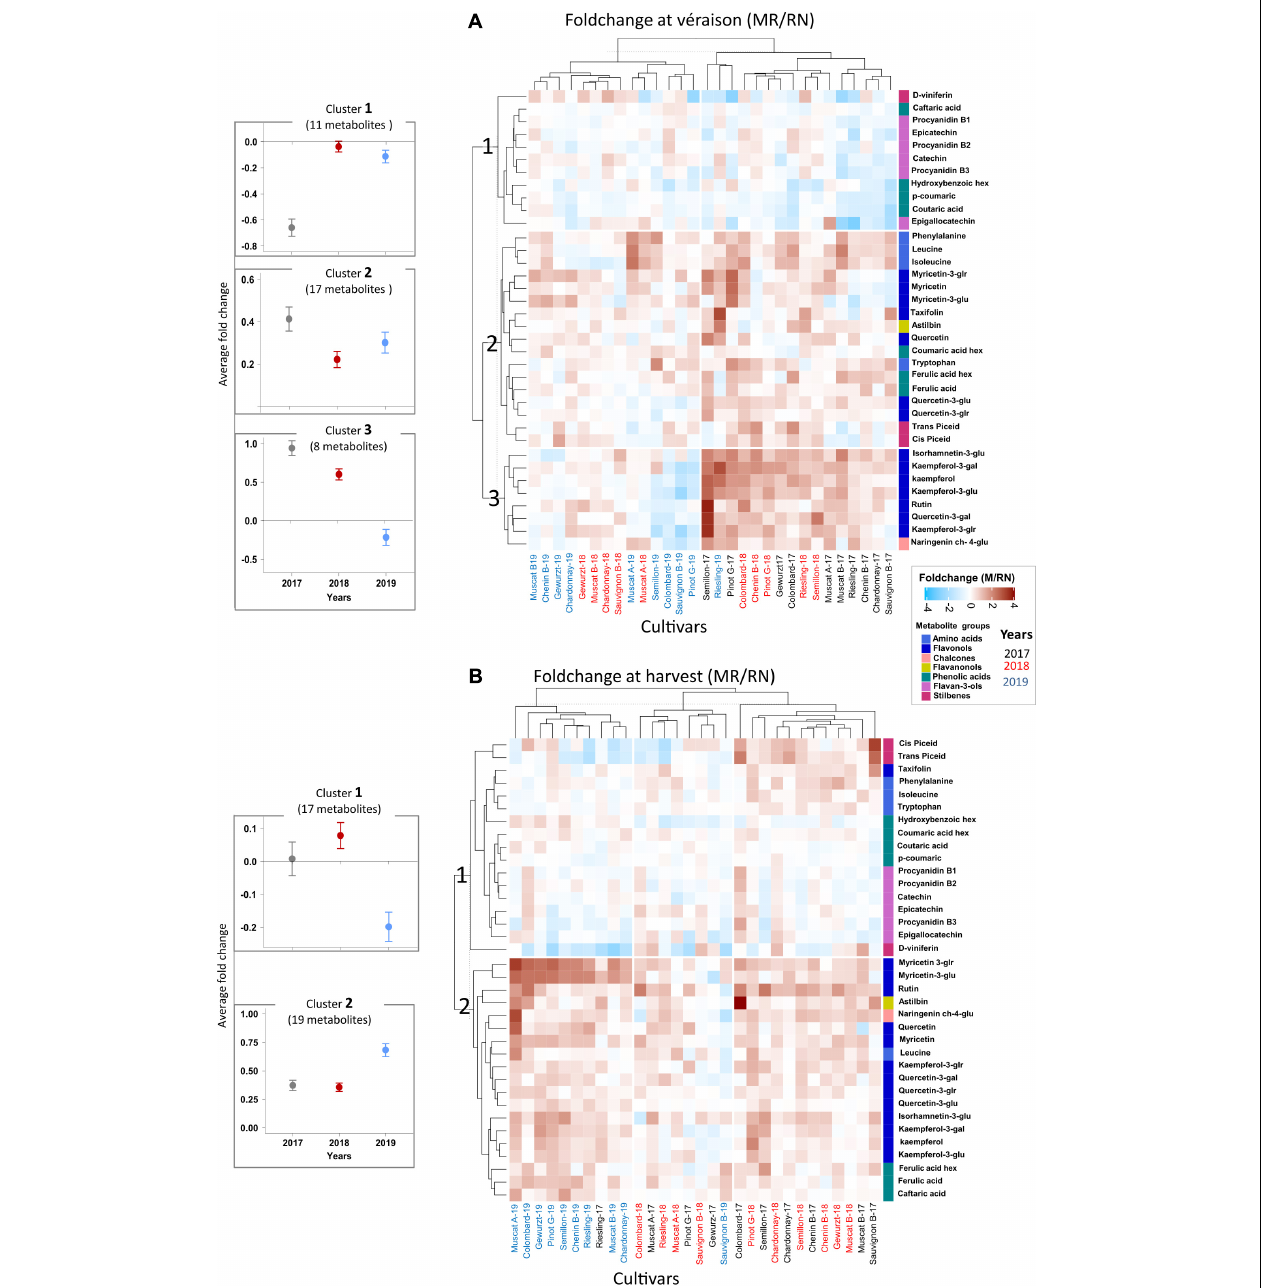
FIGURE 4 | The variability in skin phenylpropanoids at véraison (A) and harvest (B) between locations during 2017–2019, expressed as the foldchange of average response values [Mitzpe Ramon (MR)/Ramat Negev (RN)]. The mean value of each metabolite ( n = 4 biological replicates) for each cultivar in each location and season was calculated separately. Then, the MR values were divided by the RN values and transformed by log2. The heatmap was generated using the log2-transformed data. Euclidean distance was used for hierarchical clustering dendrogram. Cultivar names are denoted by vintage abbreviations (17, 18, 19). Colored cultivar names indicate samples collected in 2017 (black), 2018 (red), and 2019 (blue). Colored rectangles represent metabolite increases at MR (red) and RN (blue). A mirror heatmap of significance values is presented in Supplementary Figure 2 . The dot plots (left) indicate the average foldchange ( ± SE) of metabolites in each representative cluster in the 2017, 2018, and 2019